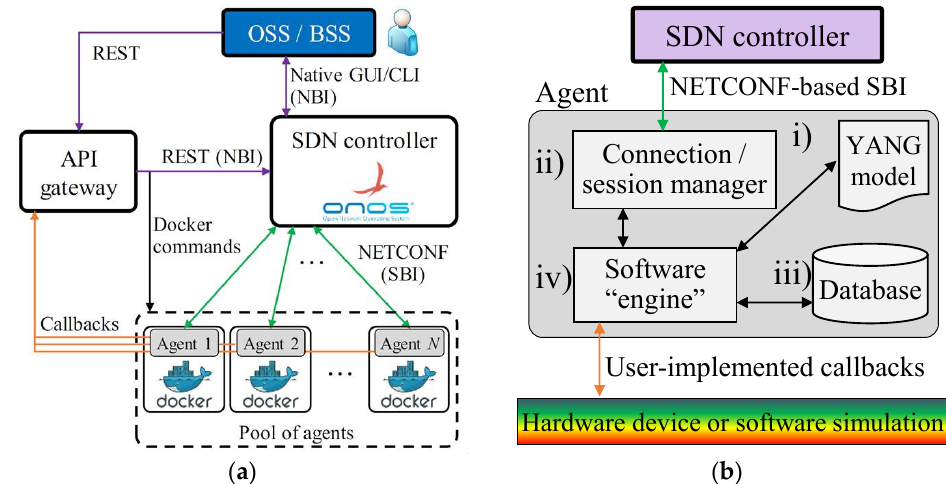
Figure 1. Architectural details of the previous work [36] ( a ) General overview of the architecture for automatic creation of agents in a software-defined optical networks (SDONs) environment; ( b ) Detailed view of the components in an optical network agent.